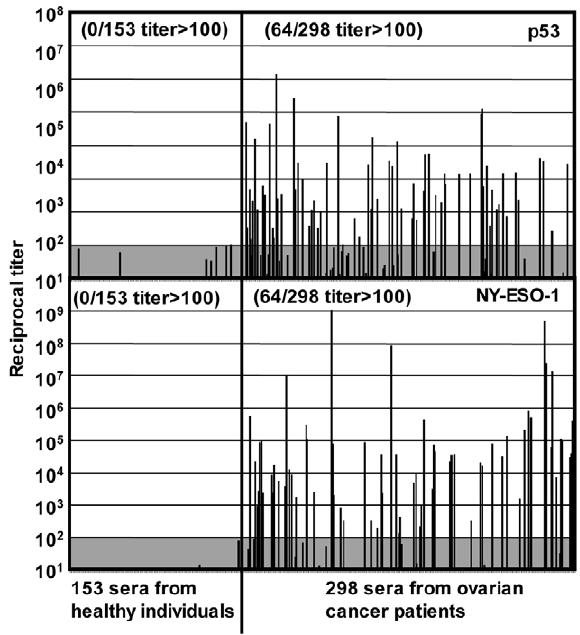
Figure 1. Spontaneous antibody responses in ovarian cancer patients. Sera from 298 ovarian cancer patients and 153 healthy individuals were evaluated for the antibody against wild-type p53 and NY-ESO-1 proteins by ELISA. Reciprocal titers are calculated as described in the reference [20].